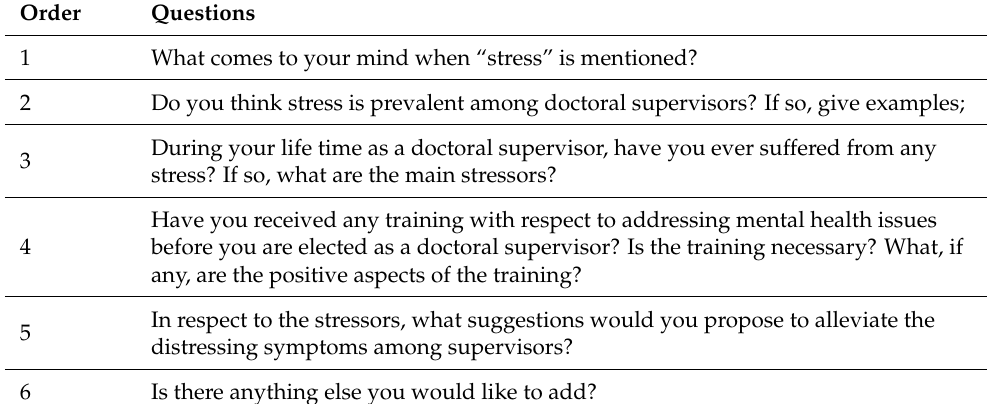
Table 1. Interview